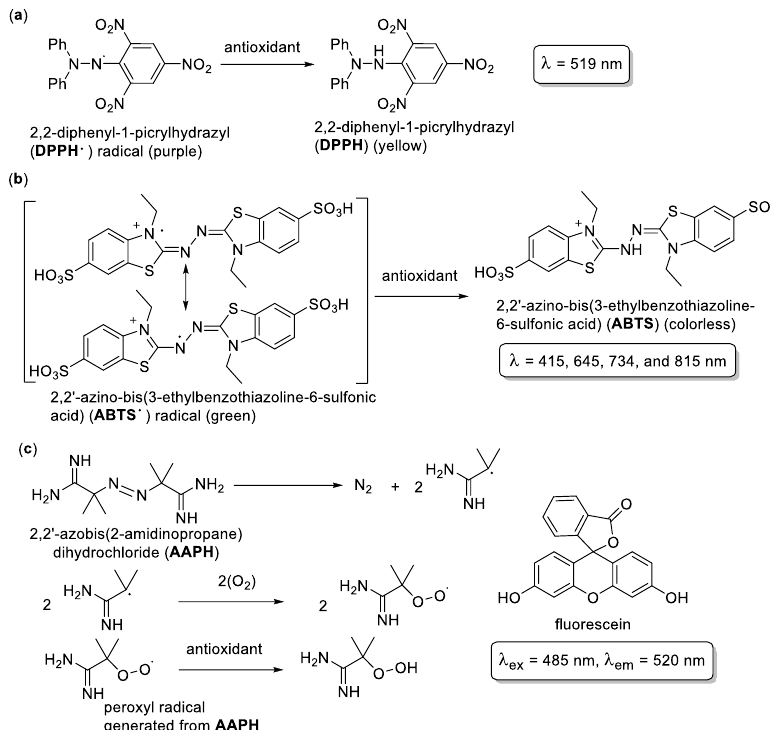
Figure 1. Chemical reactions occurring during c ommon assays to characterize the activity of radical scavengers involving stable and in situ prepared radicals. ( a ) DPPH assay; ( b ) ABTS assay and ( c ) ORAC assay.